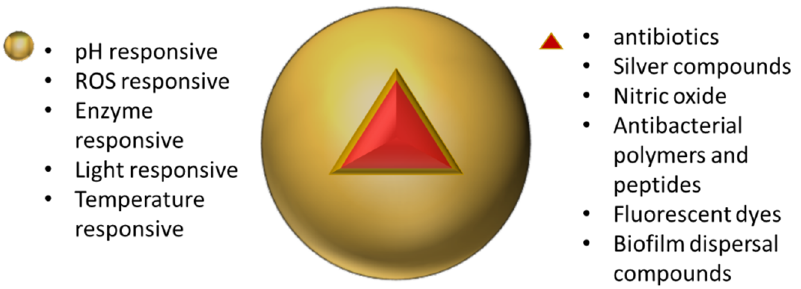
Figure 6. The core-shell architecture of a responsive (nano)material and the possible constituents of the core and shell.